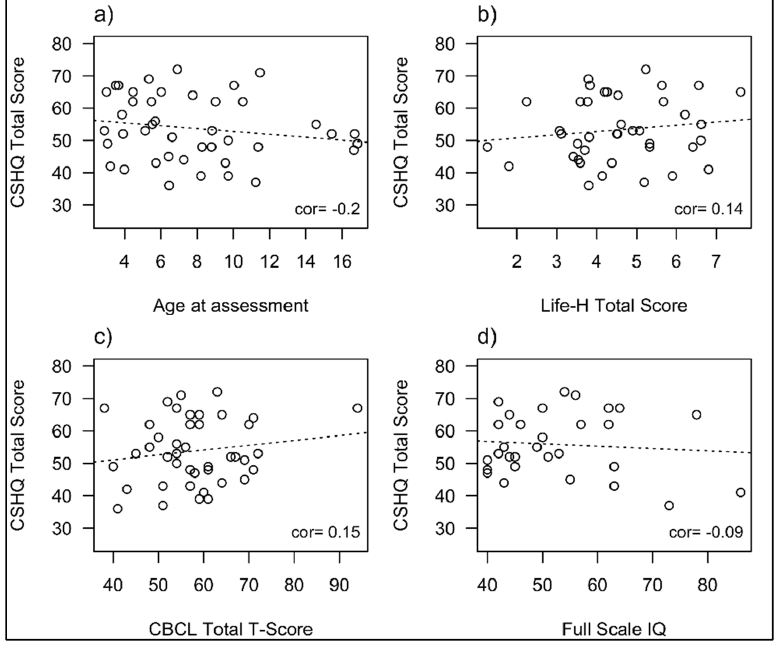
Figure 1. Relationship between sleep behaviour and age ( a ), functional ability ( b ), general behaviour ( c ) and IQ ( d ).